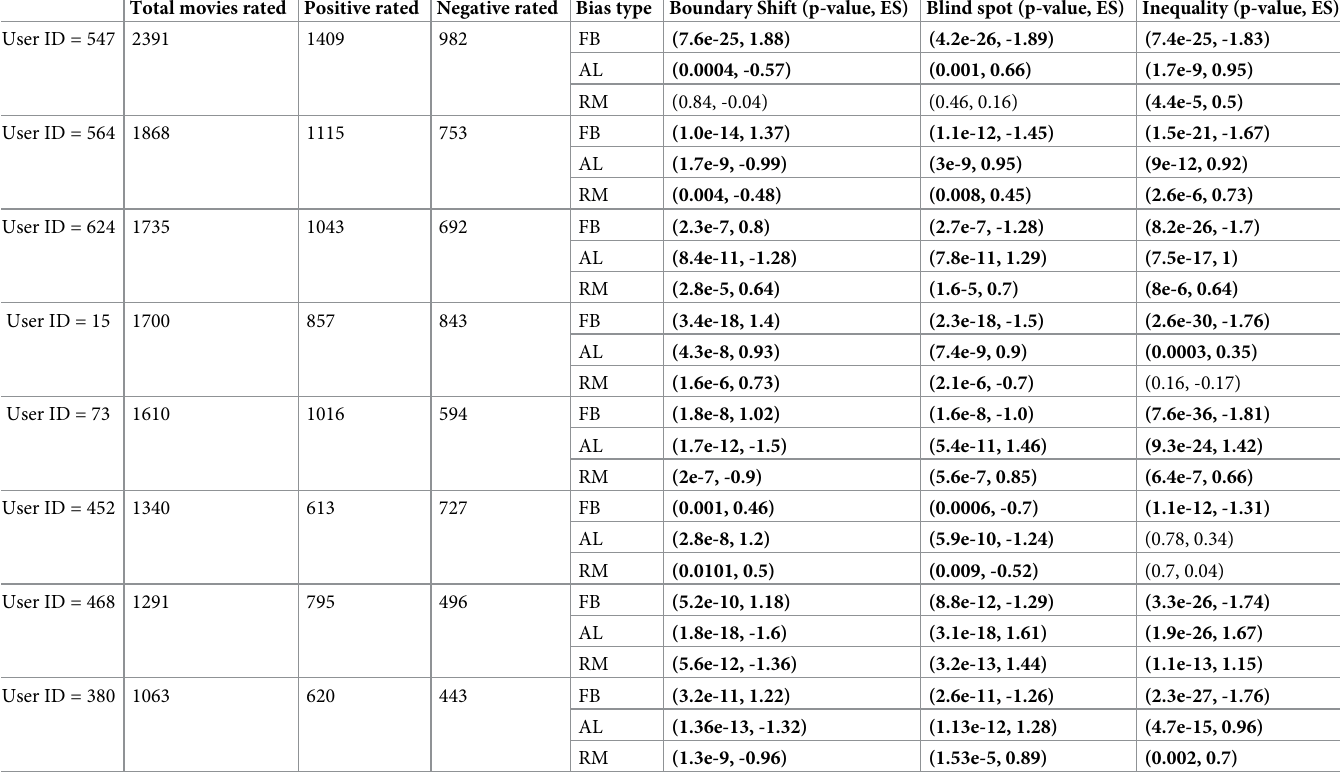
Table 18. Top 8 most active users in MovieLens data set and statistical analysis results with paired t-test. The effect size is calculated as ( Measurement | t = 0 − Measure- ment | t = 200 )/ standard . dev . Bold means significance, and ES means the effect size. Filter bias has a consistently significant and sizable effect on the three measurements across all 8 users. Random selection has less impact on the boundary shift and blind spot. However it significantly decreases the inequality. Active learning aims to help learn correct boundary, therefore it highly depends on the initial data points. Active learning affects points close to the boundary, thus it has limited effects overall. Total movies rated Positive rated Negative rated Bias type Boundary Shift (p-value, ES) Blind spot (p-value, ES) Inequality (p-value,